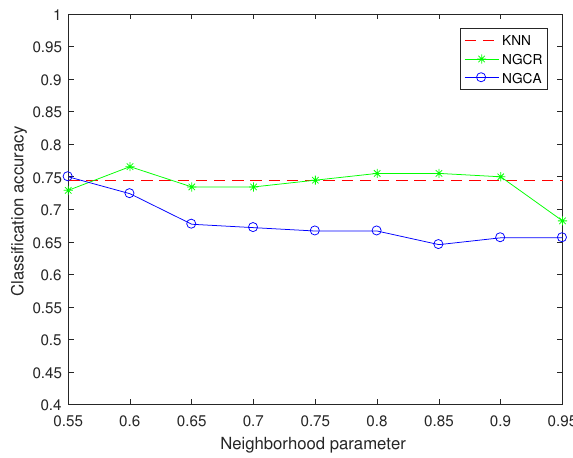
Figure 6. Classification accuracy for the pima dataset.